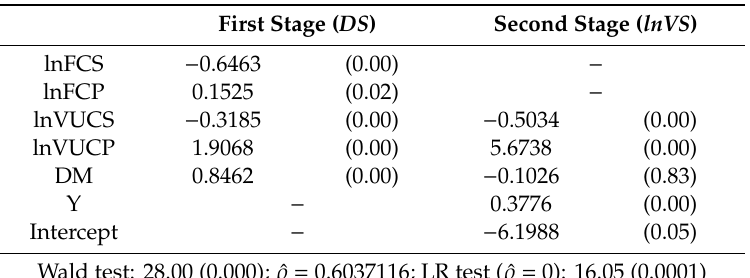
Table 3. Heckman two-stage model. Results of the